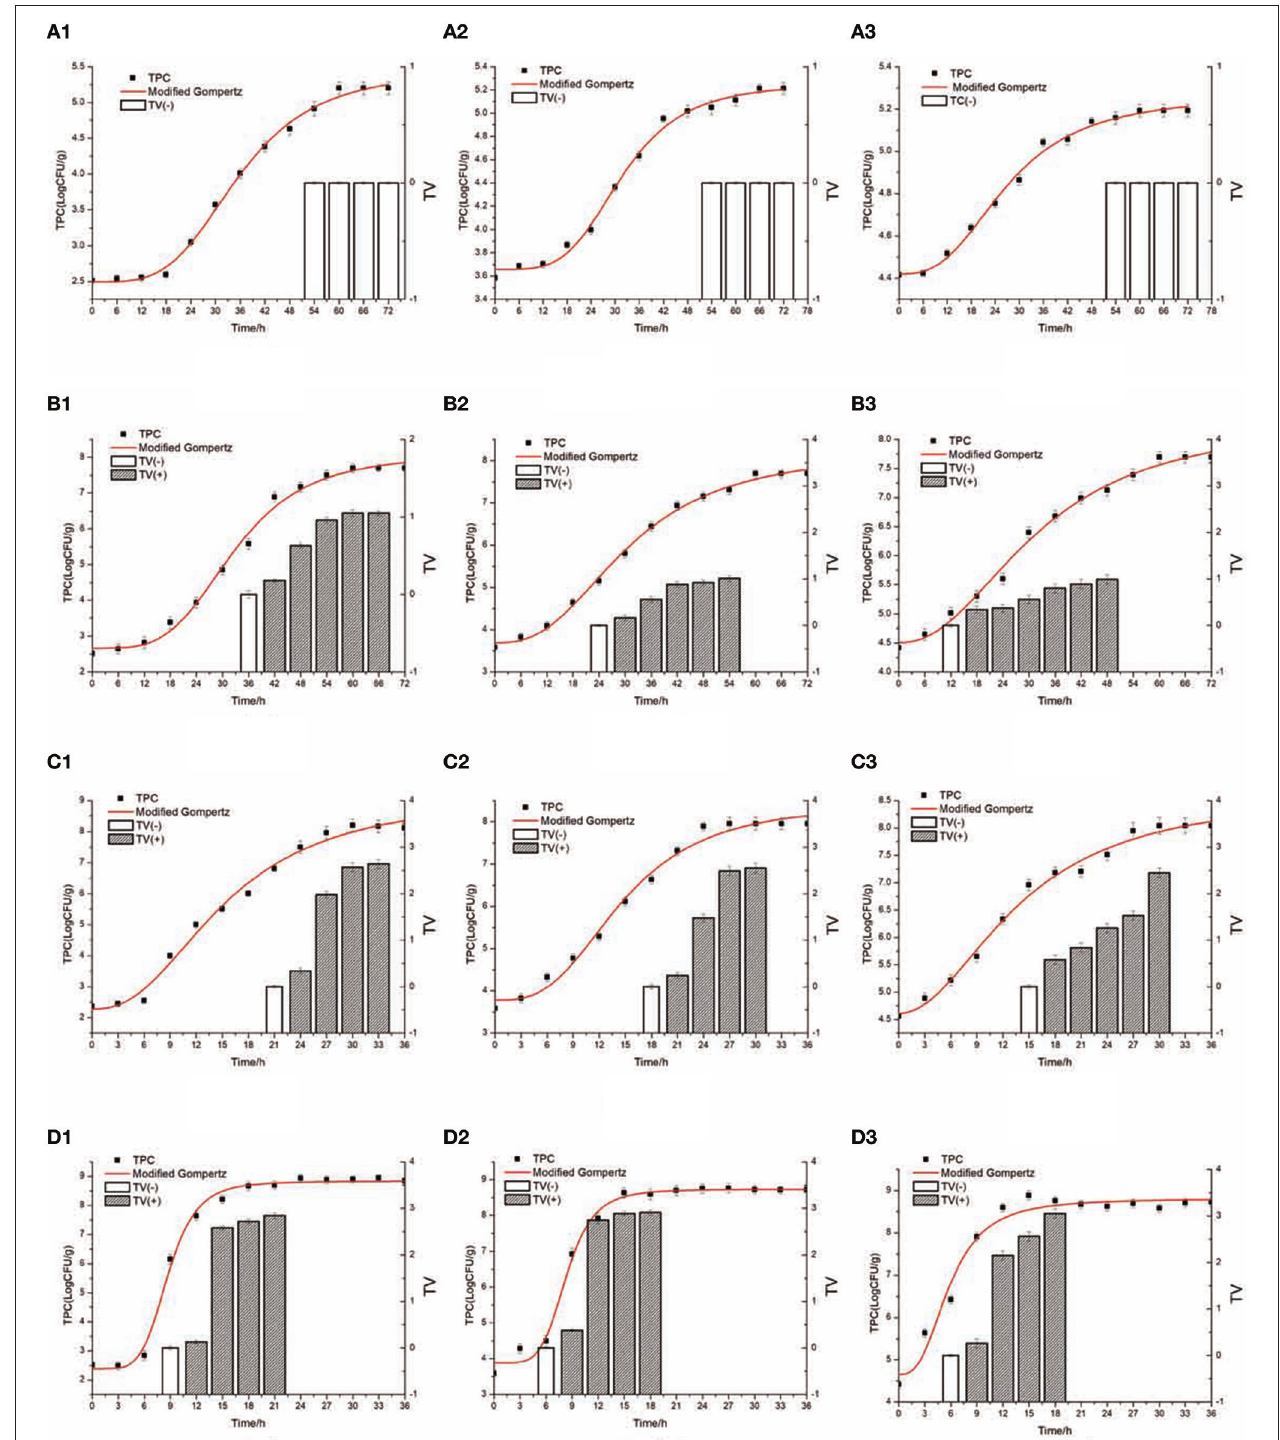
FIGURE 2 | S. aureus growth and SEA production in cooked chicken meat at 15–36 ◦ C [ (A) 15 ◦ C, (B) 22 ◦ C, (C) 29 ◦ C, (D) 36 ◦ C] with inoculating concentration approximately (1) 10 2 CFU/g, (2) 10 3 CFU/g, (3) 10 4 CFU/g. TV value ( ) of ≥ 0.13 was considered positive and SEA produced; TV value ( ) of ≤ 0.13 was considered negative and no SEA produced. The curved line with ( (cid:7) ) shows measured viable cell counts, and the curved line without squares shows the curve modeled by the modified Gompertz